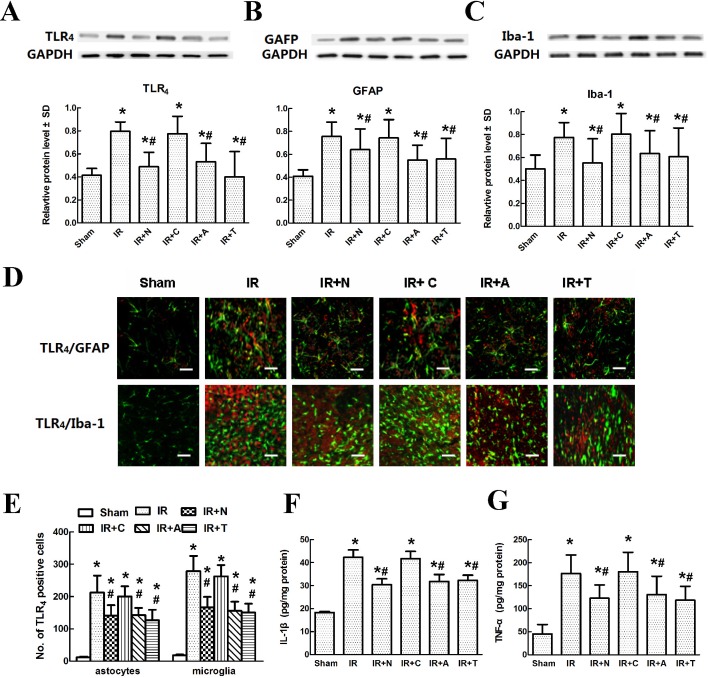
Effects of changes in spinal CXCL12/CXCR4 expression on glial TLR4 and inflammatory cytokine release after IR-induced pain.(A-C) Representative immunoblot bands for TLR4, GFAP and Iba-1. GAPDH served as an internal standard. Relative protein levels were calculated as fold increases vs. the sham group. Data are expressed as the mean ± SD. *P < 0.05 vs. the sham group; *#
P < 0.05 vs. the IR group. (D) Blocking CXCL12/CXCR4 expression in glial cells with co-localized TLR4 expression. Representative double-labeling images showing that intrathecal injection with CXCL12-neutralizing antibody, AMD3100 or TAK-242 significantly prevented microglia and astrocytes from up-regulating TLR4 at 48 h post-surgery. Scale bars represent 100 μm. (E) Quantification of TLR4-positive astrocytes or microglia in the spinal cord after IR-induced pain. (F-G) Blocking CXCL12/CXCR4 expression and inflammatory cytokine release after IR-induced pain. Quantification of IL-1β and TNF-α production in the spinal cord by ELISA. Data are expressed as the mean ± SD. *P < 0.05 vs. the sham group; *#
P < 0.05 vs. the IR group.